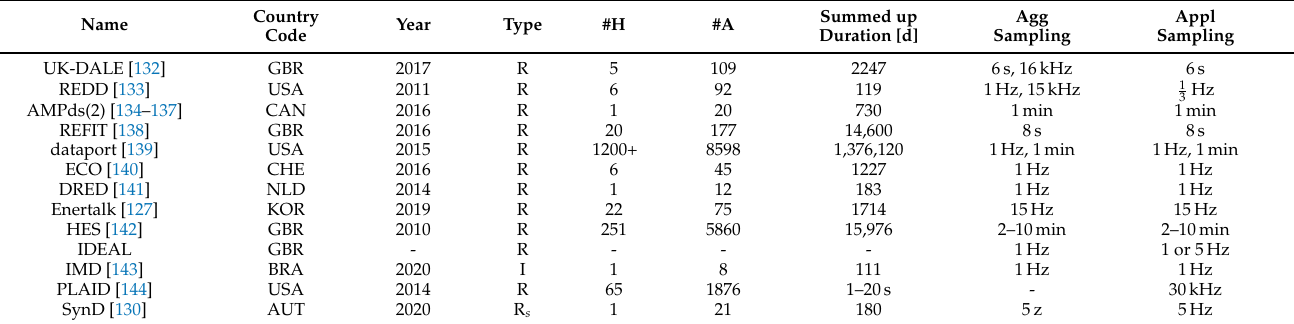
Table 3. Main characteristics of the open datasets used in the reviewed DNN-NILM literature, see Table 2. Datasets closer to the top have been employed in more studies. Type indicates the type of the dataset: R → residential, R s → synthetic residential, I → industrial. IMD is, to our knowledge, the only publicly available industrial dataset. ’#H’ and ’#A’ mean number of houses and appliances, respectively. ’ Agg ’ and ’ Appl ’ stand for ’aggregate’ and ’appliance’, respectively. For the IDEAL dataset, available information has been extracted from [98]. The authors plan to release the